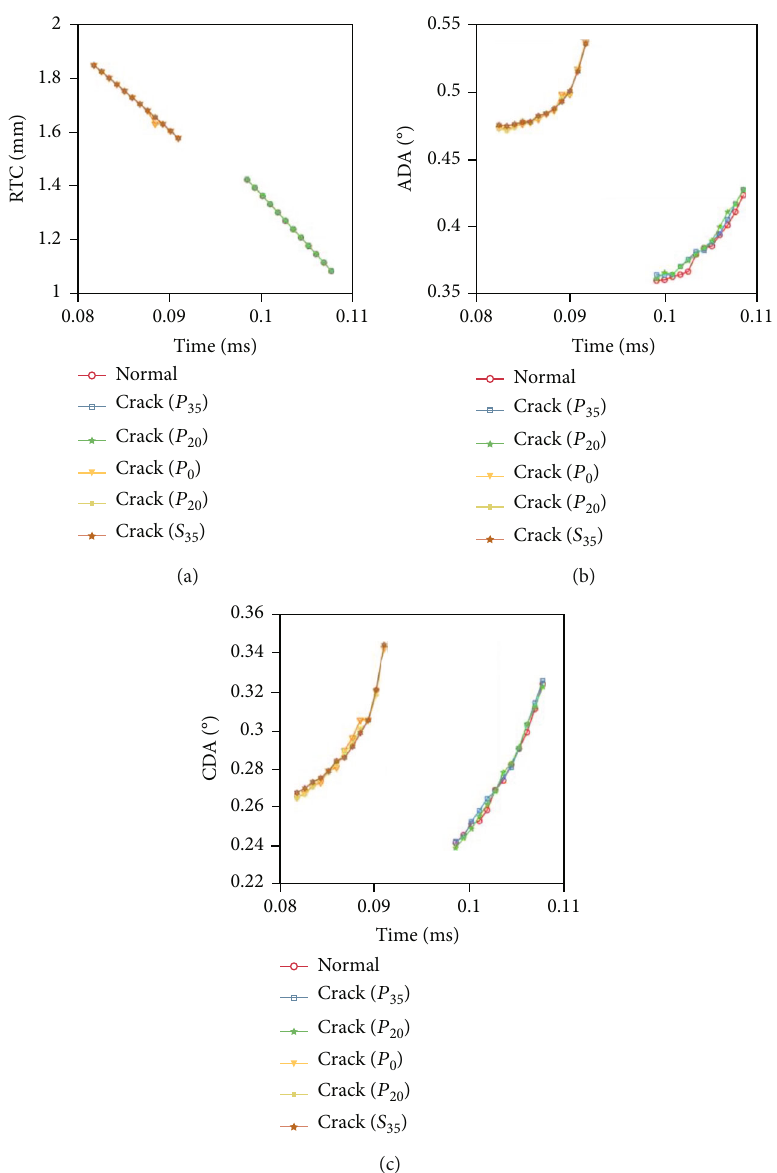
Figure 17: The 3D-BTC of blades with surface cracks of di ff erent positions. (a) RTC (b) ADA. (c)